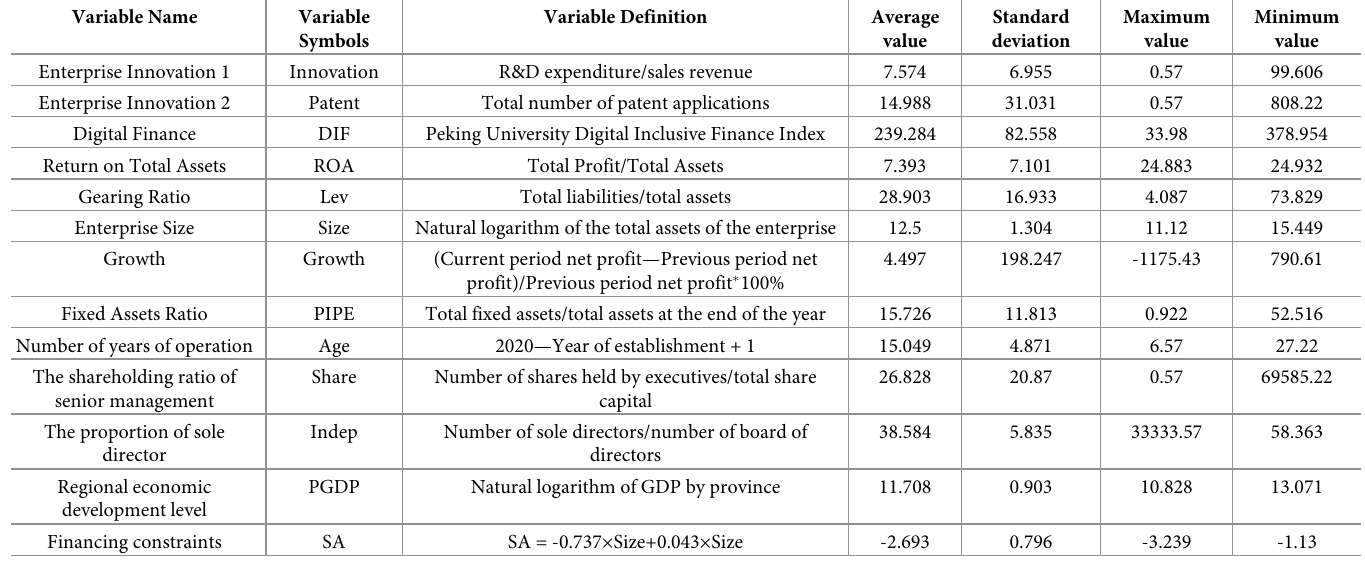
Table 1. Definition of primary variables and descriptive